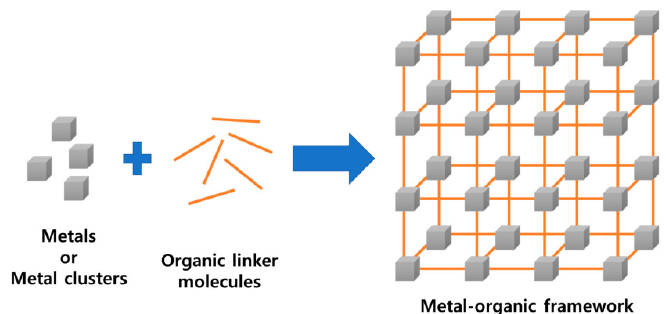
Figure 1. Schematic representation of MOFs [1]. Reproduced with permission.